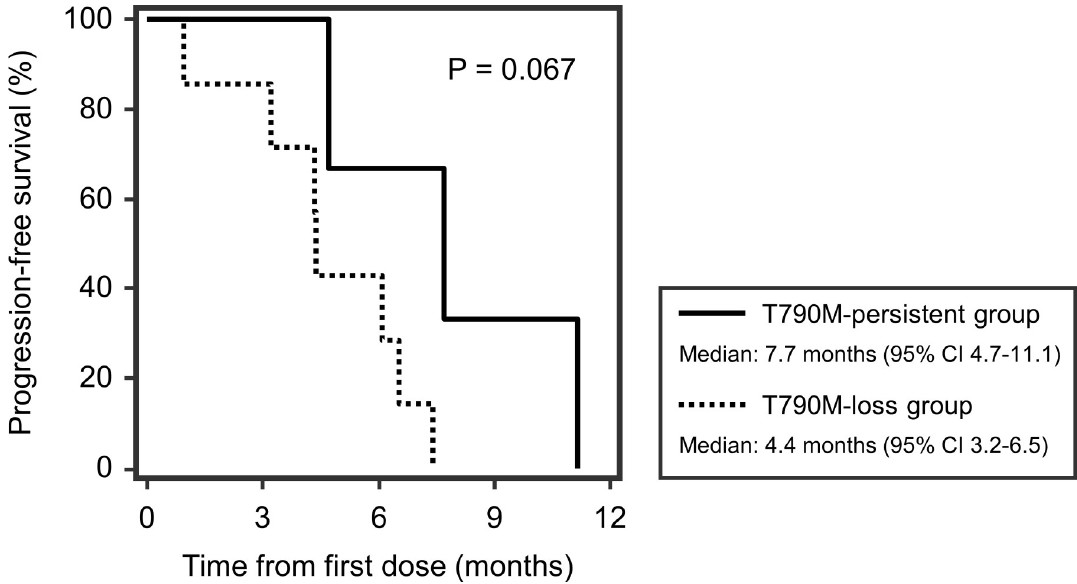
Fig 5. Comparison of progression-free survival between the T790M-persistent group and the T790M-loss group. Abbreviation: CI, confidence interval.